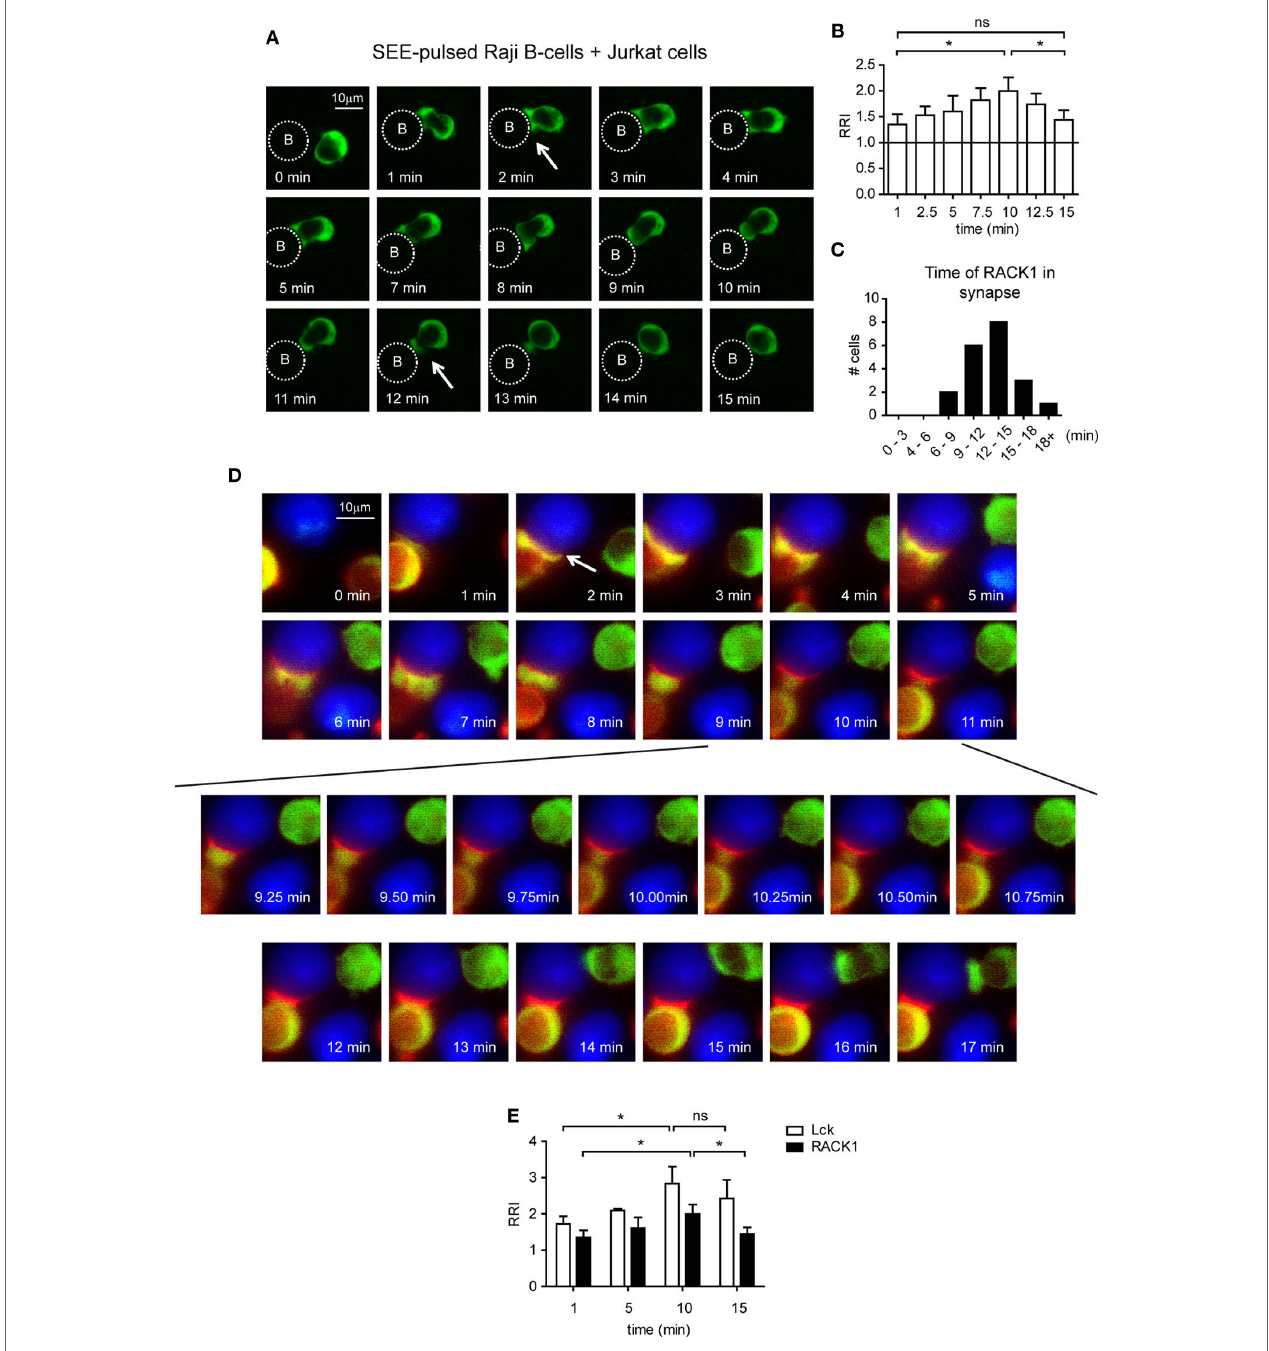
FigUre 3 | The kinetics of lck and racK1 co-redistribution into forming immunological synapses (is) in Jurkat T-cells . (a) Jurkat T-cells expressing RACK1–EGFP (green) were mixed with SEE-pulsed RAJI B-cells (denoted by the dotted circle), and the redistribution of RACK1 was observed by live cell imaging microscopy. Sequential time-lapse fluorescence microphotographs from one representative movie (Video S1 in Supplementary Material) are shown. (B) Statistical analysis of the kinetics of the relative recruitment index (RRI) of RACK1 to the forming IS measured after cell contact initiation ( n = 20). (c) The bar graph shows the time distribution of RACK1 residency in IS; the start and end points of RACK1 residency are marked by two white arrows shown in (a) ; n = 20 cells. (D) Lck- deficient JCAM1.6 Jurkat T-cells co-expressing Lck–CFP (red) and RACK1–mCitrine (green) constructs were mixed with SEE-pulsed RAJI B-cells (blue). Their redistribution during the formation of IS was observed by live cell imaging microscopy. Sequential time-lapse fluorescence microphotographs from one representative movie (Video S2 in Supplementary Material) are shown. An arrow points to the forming IS. (e) Statistical analysis of the kinetics of the relative recruitment index (RRI) of RACK1 and Lck to the forming IS measured after cell contact initiation ( n =